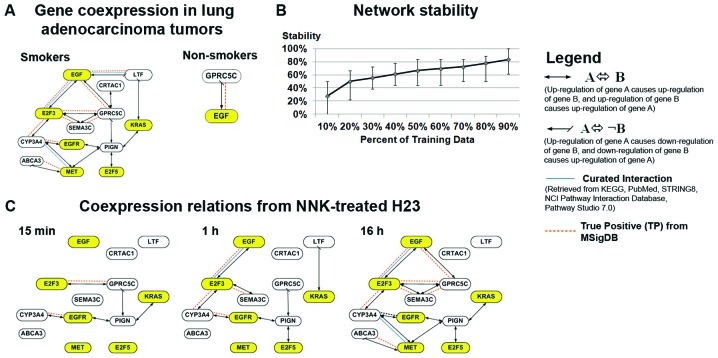
Smoking-associated coexpression network in lung adenocarcinoma. (A) Gene coexpression relations specific to smokers and non-smokers significant (P<0.05) in both training and test sets from Shedden et al(15) (network precision = 0.91, FDR = 0.01). (B) The stability of smoking-mediated networks as evaluated with random subsets of patients from the training cohort in 100 iterations. (C) Coexpression relations observed in the NNK-treated H23 cell line for 15 min, 1 and 16 h.